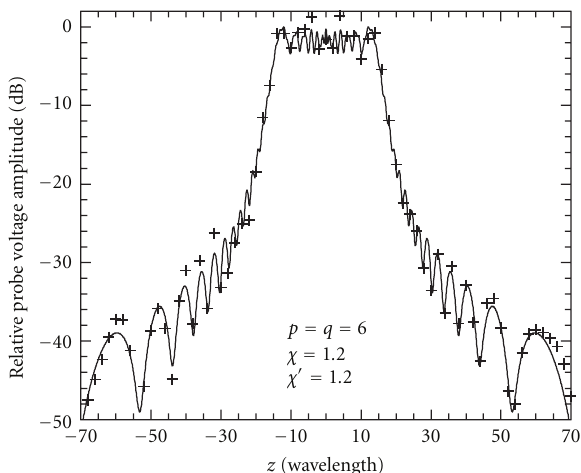
Figure 2: Amplitude of the probe voltage V on the generatrix at ϕ = 90 ◦ . Solid line: exact. Crosses: recovered from irregularly spaced NF data at the iteration